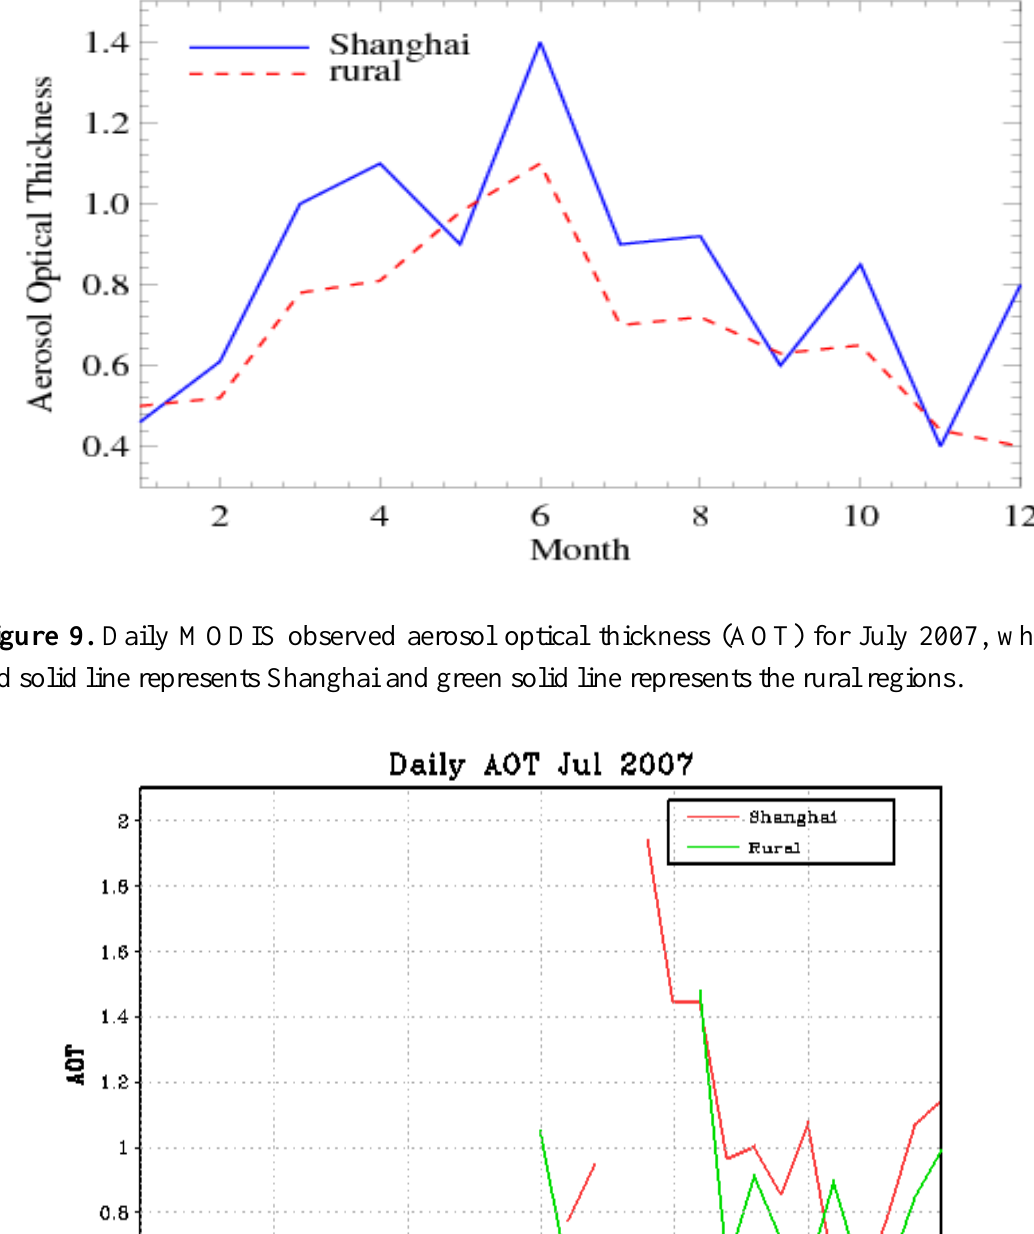
Figure 8. Monthly aerosol optical thickness (AOT) from MODIS in 2004, where the solid line represents Shanghai and the dashed line represents the rural regions.